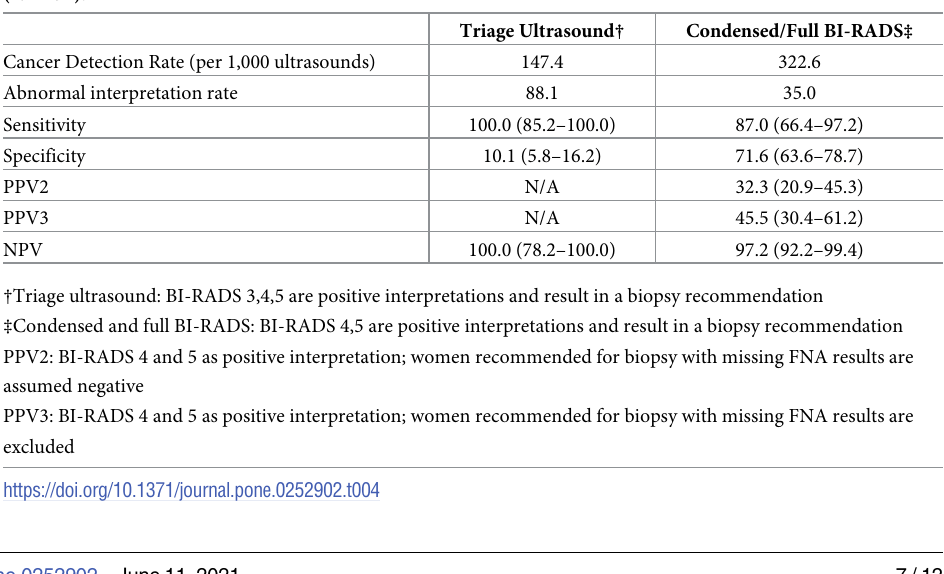
Table 4. Interpretive performance of primary care physicians based on actual and alternative reporting systems (N =